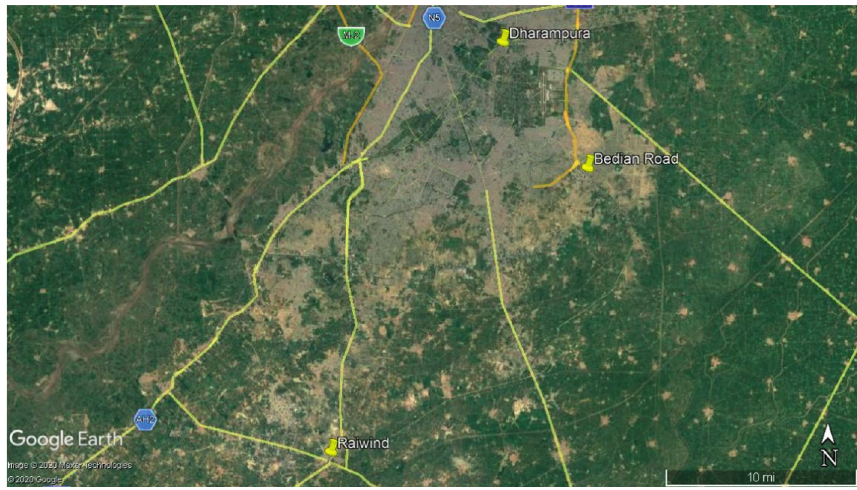
Figure 1: Map of the study